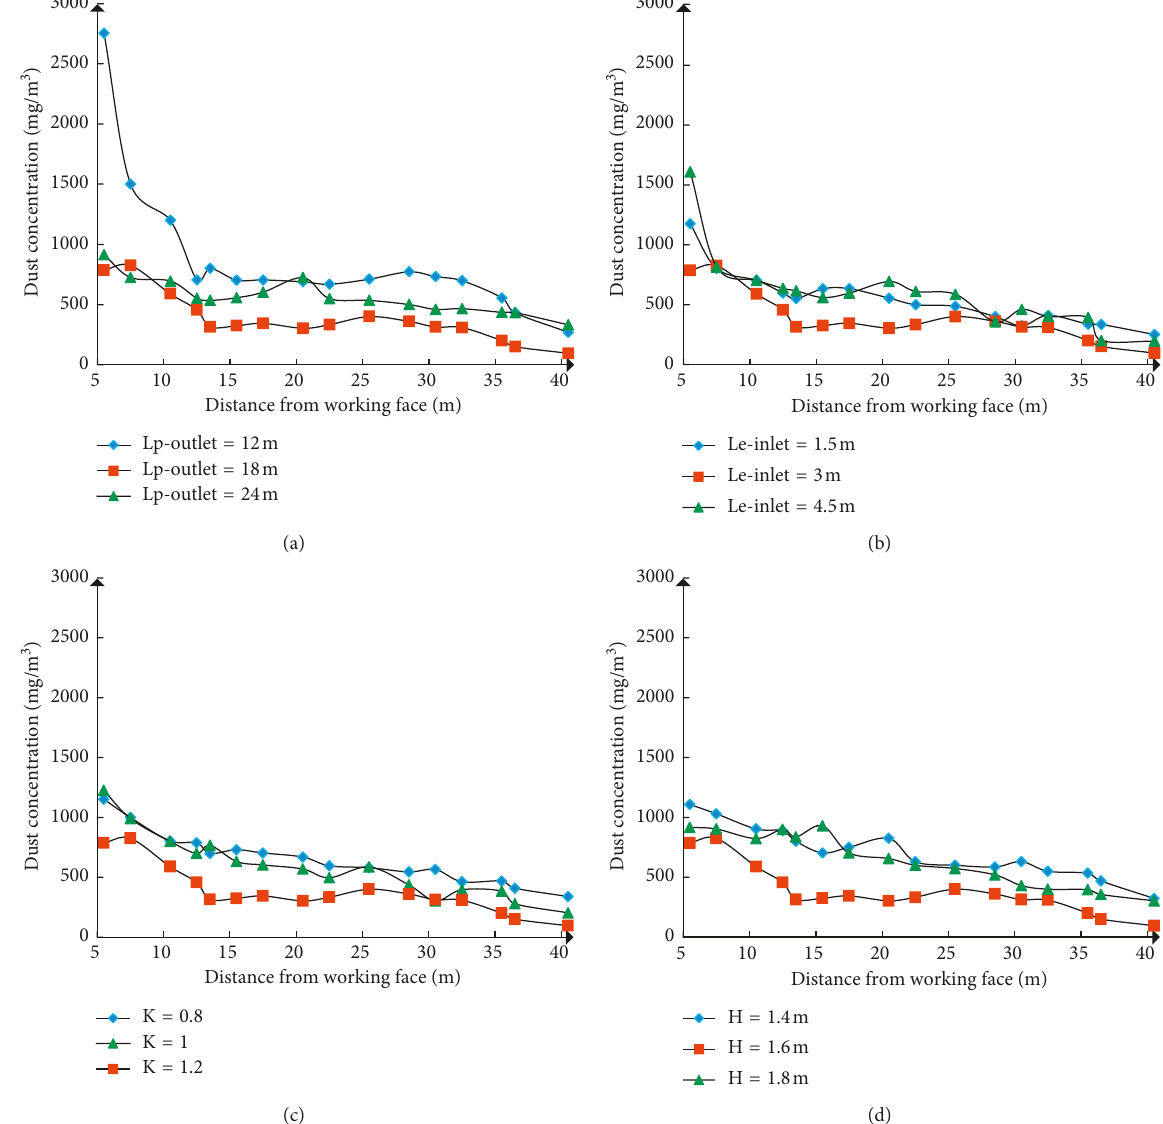
Figure 11: Dust concentration along the roadway at the breathing zone under the influence of different parameters. (a) L (c) K , and (d) H .